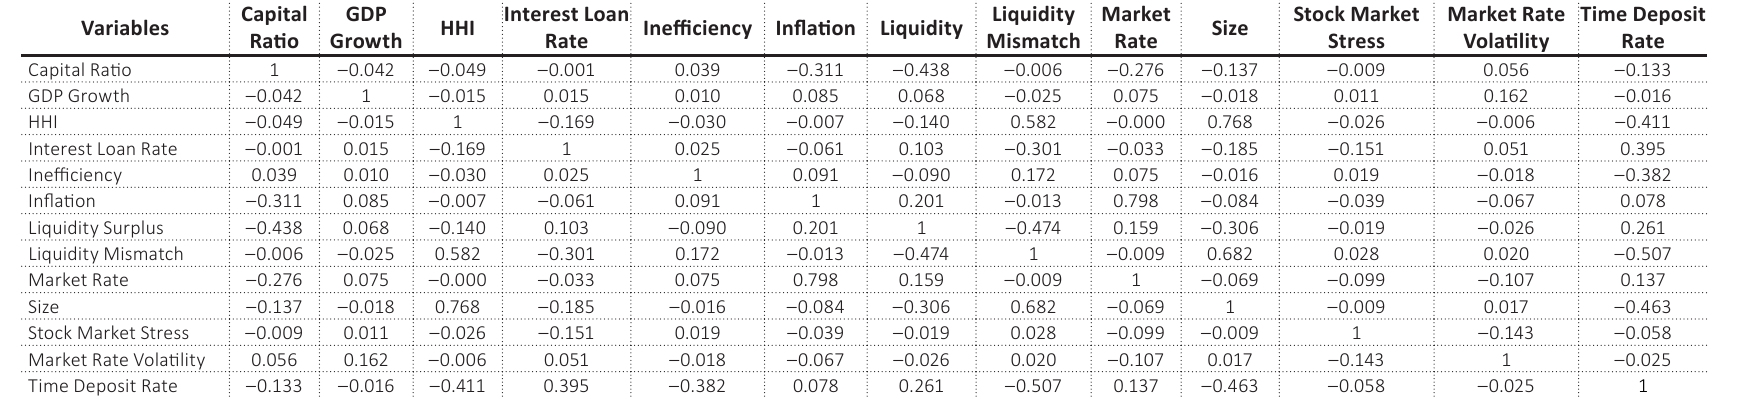
Table B2. Correlation within variables from equation 3 (Time Deposit Rate –